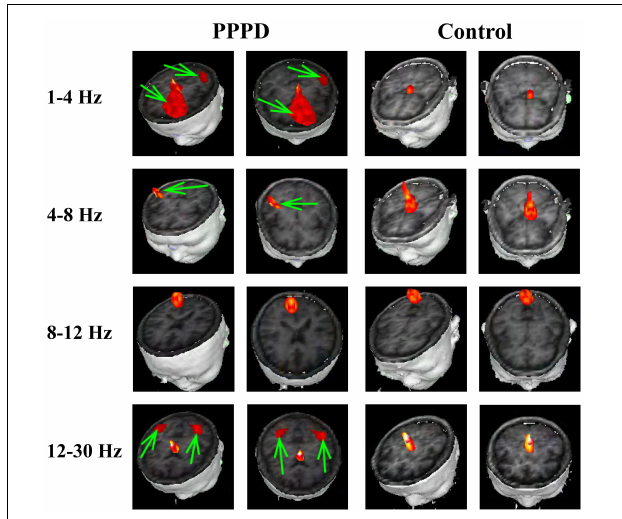
FIGURE 1 | Typical distribution of neuromagnetic source localization in 1–30 Hz frequency bands in PPPD patients and controls. Green arrows indicate the significant difference in source localization in PPPD patients compared with the controls.